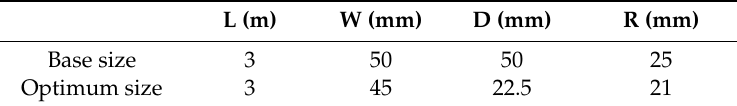
Table 11. The dimension of channels compared in Figure